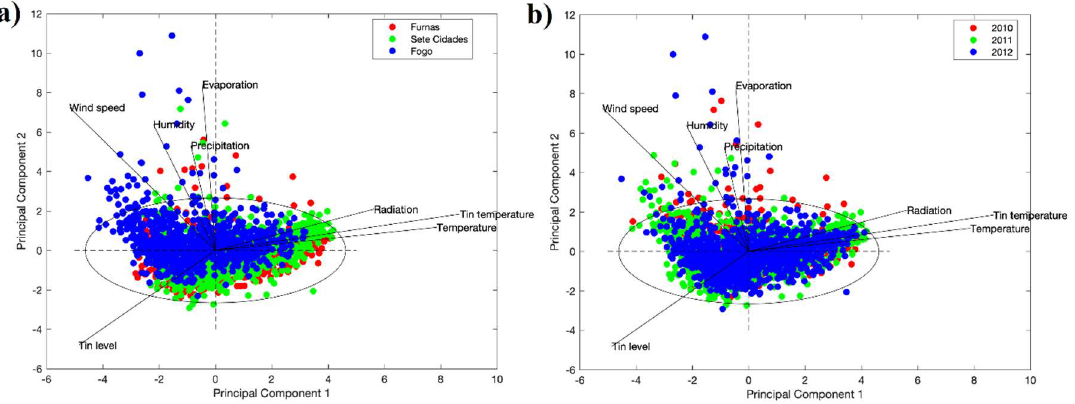
Figure 8. Biplots for the multivariate analysis of the meteorological data, colored according to lakes ( a ) and years from data collection ( b